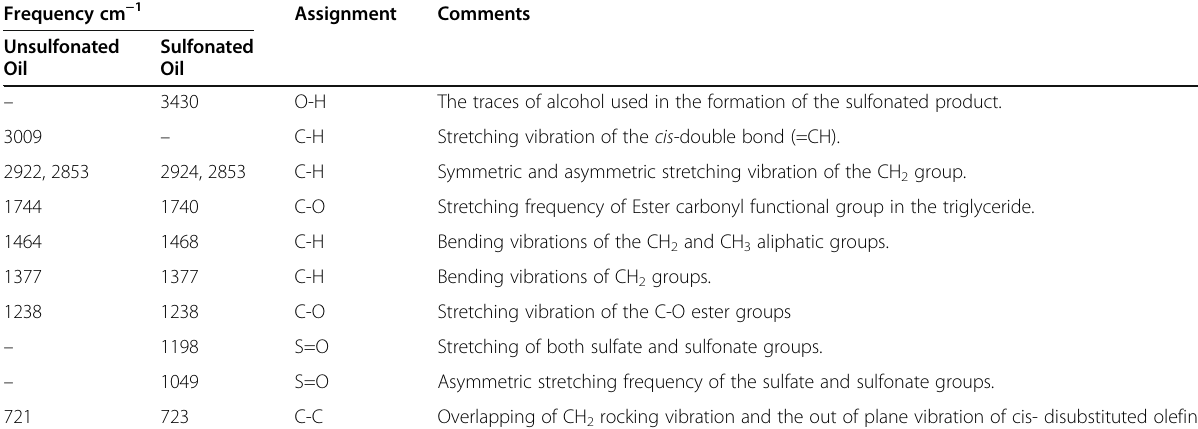
Table 4 Evaluation of the FT-IR